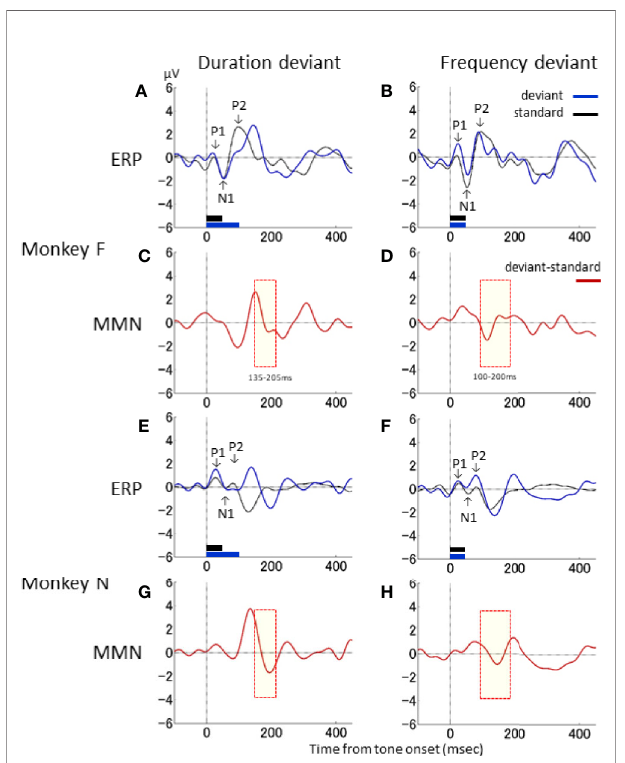
FIGURE 3 | Waveform characteristics of ERP. Responses to the standard (black) and deviant (blue) stimuli, and the differential waveform (red), are shown for the duration-deviant (A, C, E, G) and frequency-deviant (B, D, F, H) experiments conducted on monkey F (A – D) and monkey N (E – H) . Conventions are the same as in . The yellow shaded area denotes the time window of the dMMN (C, G) and fMMN (D, H) in Nagai et al. (13).